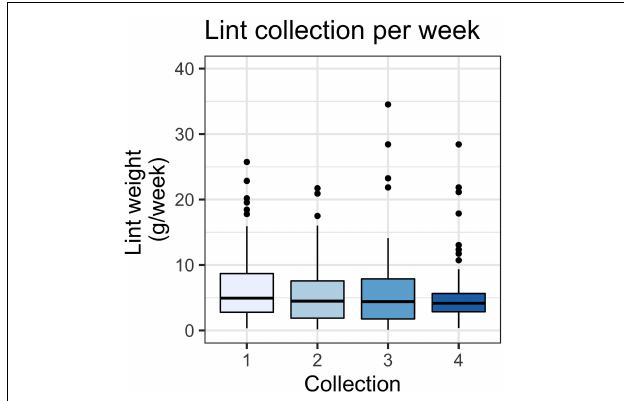
FIGURE 1 | Weight of lint in g/week for lint captured in household filters across four collection periods ( n1 = 73, n2 = 51, n3 = 60, and n4 = 62). A Kruskal-Wallis test showed no significant difference between collection periods ( p > 0.05). Boxes represent 25th–75th percentiles; dark lines, medians; whiskers, 1.5 × the interquartile range (IQR); points, values outside 1.5 × the IQR.